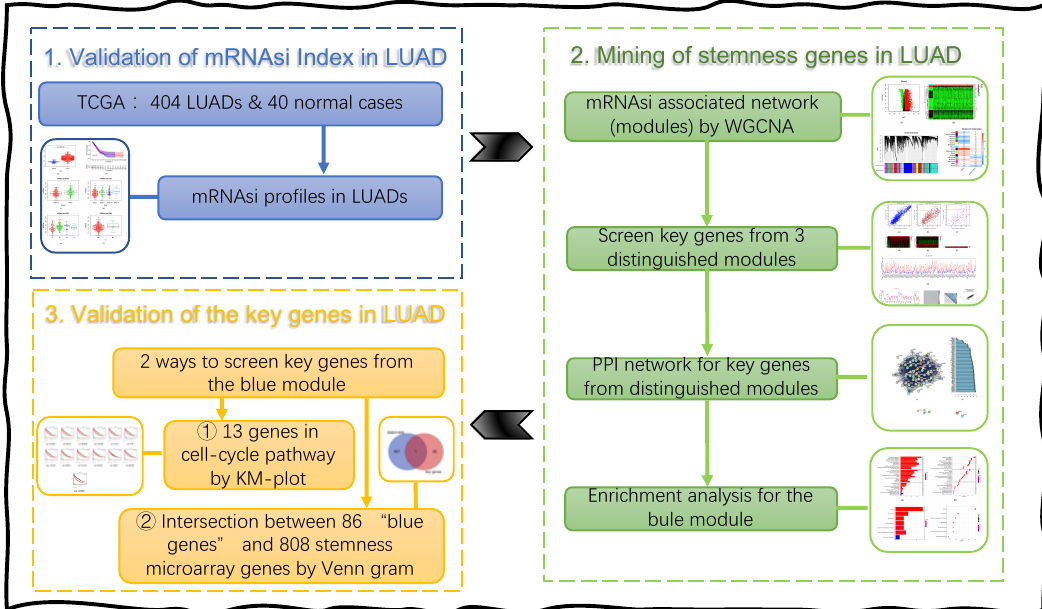
Figure 2. The workflow of this work. Abbreviations are defined as follows, Lung adenocarcinoma (LUAD), the Cancer Genome Atlas (TCGA), Kaplan–Meier-plot (KM-plot), weighted gene co-expression network analysis (WGCNA), and protein–protein interaction